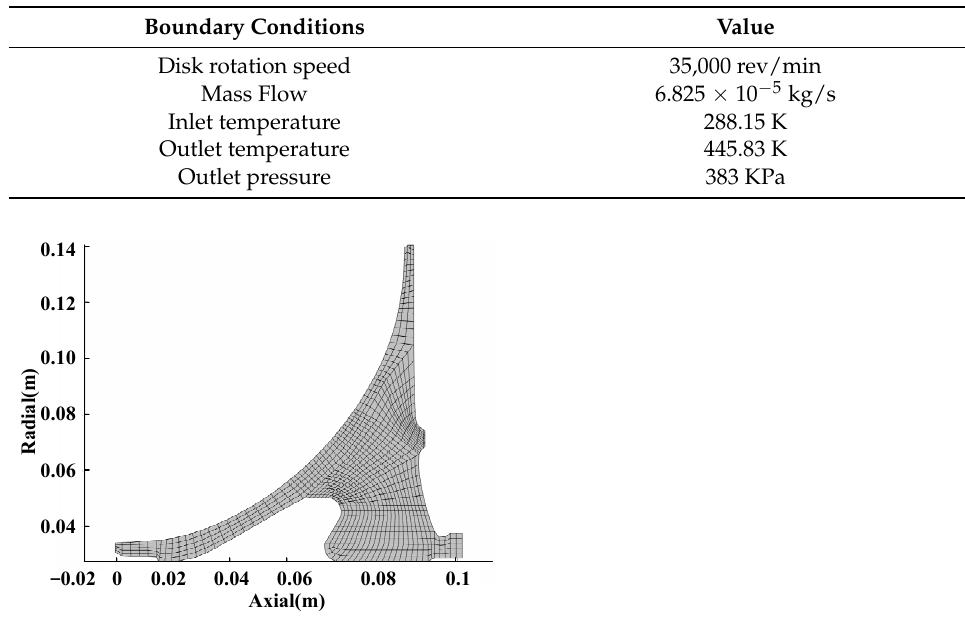
Table 1. Boundary conditions in the steady state.